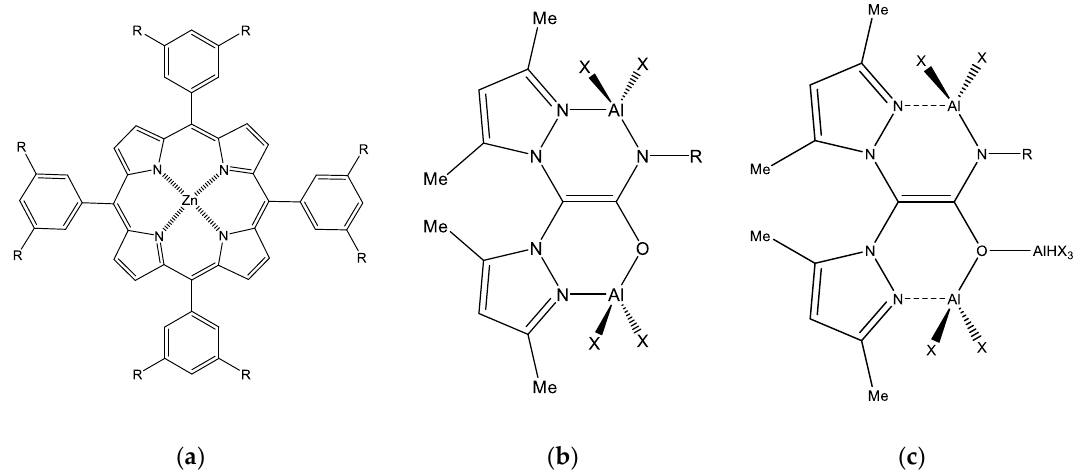
Figure 7. Non-salen-based complexes: ( a ) metalloporphyrin-based complex; ( b ) binuclear aluminum scorpionate; ( c ) trinuclear aluminum scorpionate.